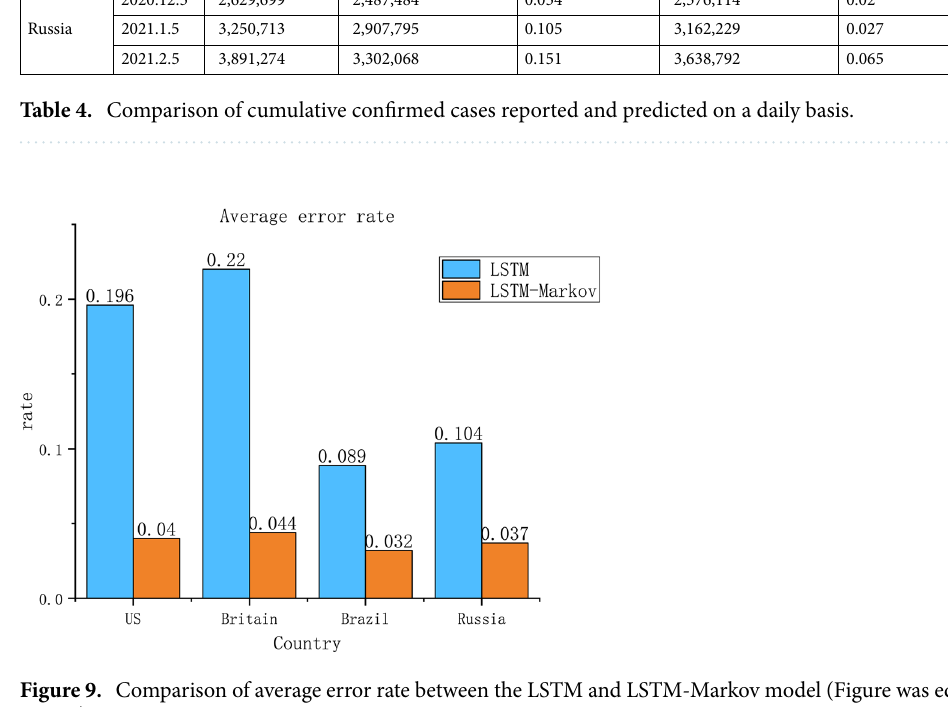
Figure 9. Comparison of average error rate between the LSTM and LSTM-Markov model (Figure was edited by